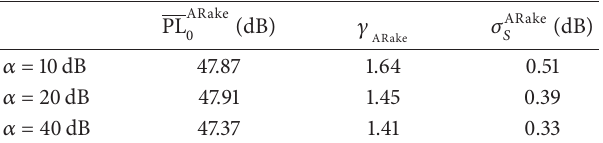
Figure 5: Scatter plot of path loss versus Tx-Rx separation distance. The solid line corresponds to the linear fit. Table 2: ARake path loss values derived from a linear fit to the measured data in terms of the threshold level ( 𝛼 ).